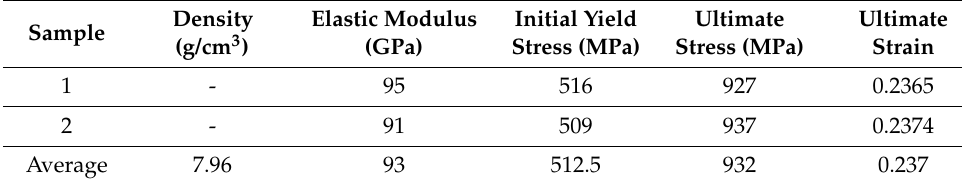
Figure 5. Finite element model of the Bambusa-lattice. Table 3. Material parameters of the parent material 316 L stainless steel [29].